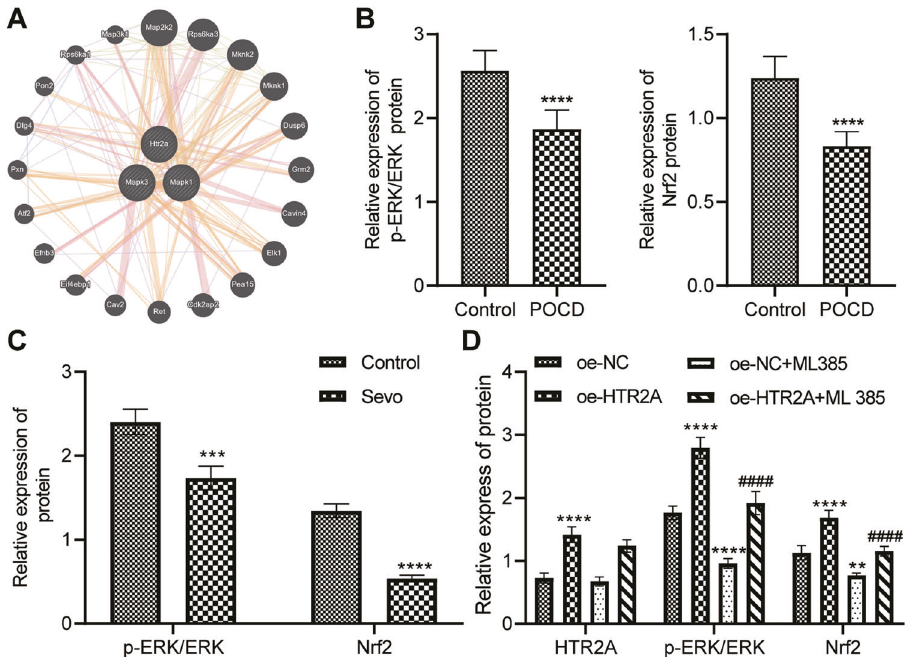
Fig. 3 HTR2A overexpression results in activation of ERK/Nrf2 pathway in hippocampal neurons of POCD rats. A Bioinformatics software predicted that HTR2A was involved in ERK/Nrf2 pathway. B Western blot analysis of the protein expression of Nrf2 and the phosphorylated ERK/total ERK protein expression ratio in the hippocampal tissues (10 rats/group, * p < 0.05, ** p < 0.01, and *** p < 0.001 vs. the rats without Sevo inhalation). C Western blot for determining the protein expression of and Nrf2 and phosphorylated ERK/total ERK protein expression ratio in rat hippocampal neurons (The experiment was repeated three times; * p < 0.05, ** p < 0.01, and *** p < 0.001 vs. the rats without Sevo inhalation). D The p rotein expression of HTR2A and Nrf2 and phosphorylated ERK/total ERK protein expression ratio in rat hippocampal neurons by Western blot analysis (The experiment was repeated three times; * p < 0.05, ** p < 0.01, and *** p < 0.001 vs. the neurons treated with oe-NC; # p < 0.05, ## p < 0.01, and ### p < 0.001 vs. the neurons with oe-HTR2A